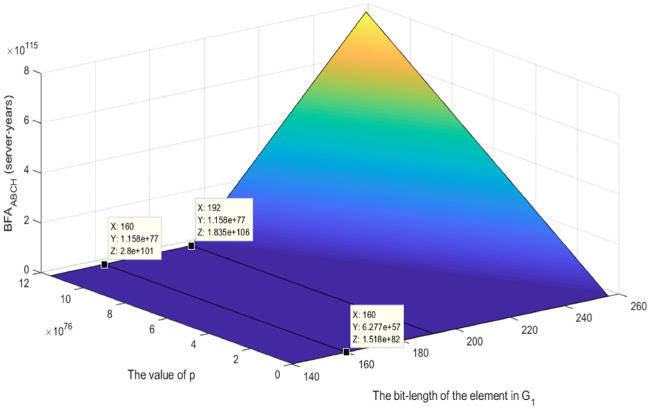
Cost of BFAAECH vs. the bit-lengths of the element in G1 and p.